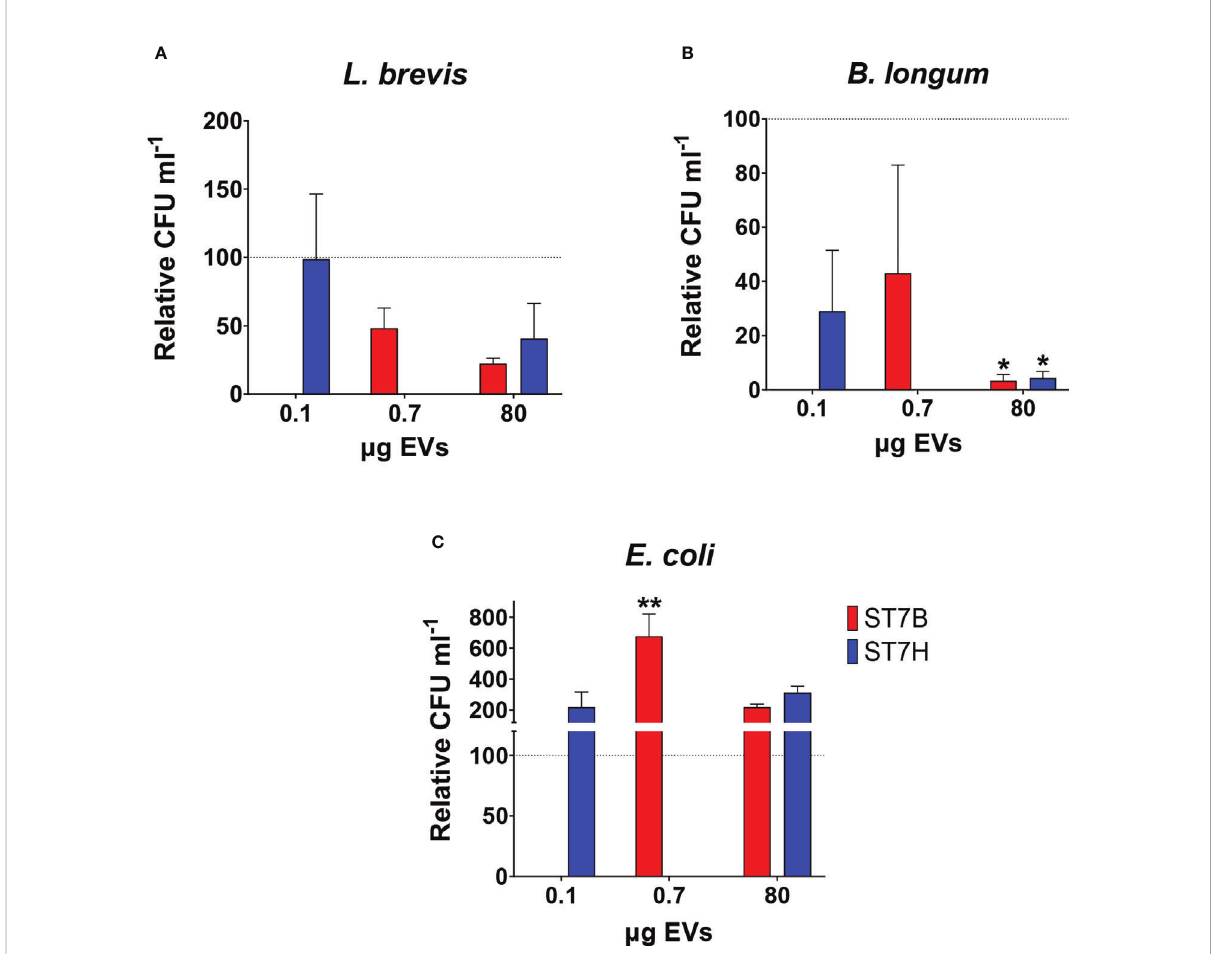
FIGURE 4 Blastocystis ST7 EVs cause a reduction in B longum while increasing E coli growth. Coculture of Blastocystis ST7 EVs with three species of physiologically relevant human gut microbiota in PBS: (A) Lactobacillus brevis , (B) Bi fi dobacterium longum , and (C) Escherichia coli . Bars represent level of prokaryote growth following 24 hours coculture as mean ± SD. Two standard quantities of EV were used: 80 µg, the amount required to produce the effect observed in Figure 3B, and 10 7 EVs (converted to µg in this fi gure). Statistical testing performed using